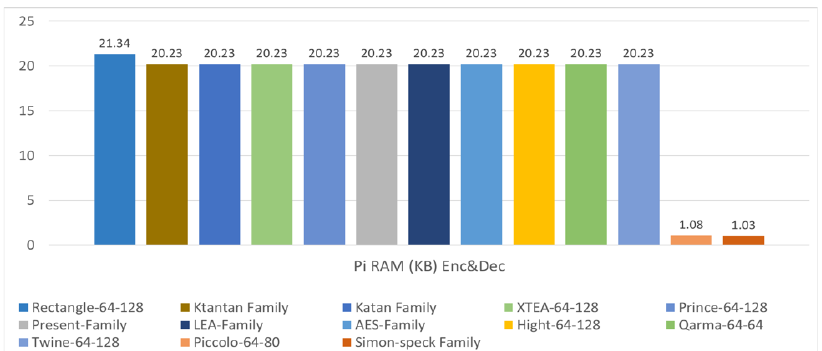
Figure 7. The 10 smallest ciphers RAM usage and 5 largest for